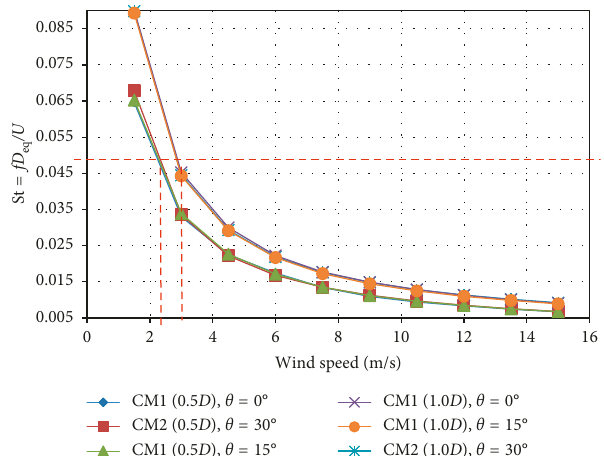
Figure 15: Normalized frequency (St � fD